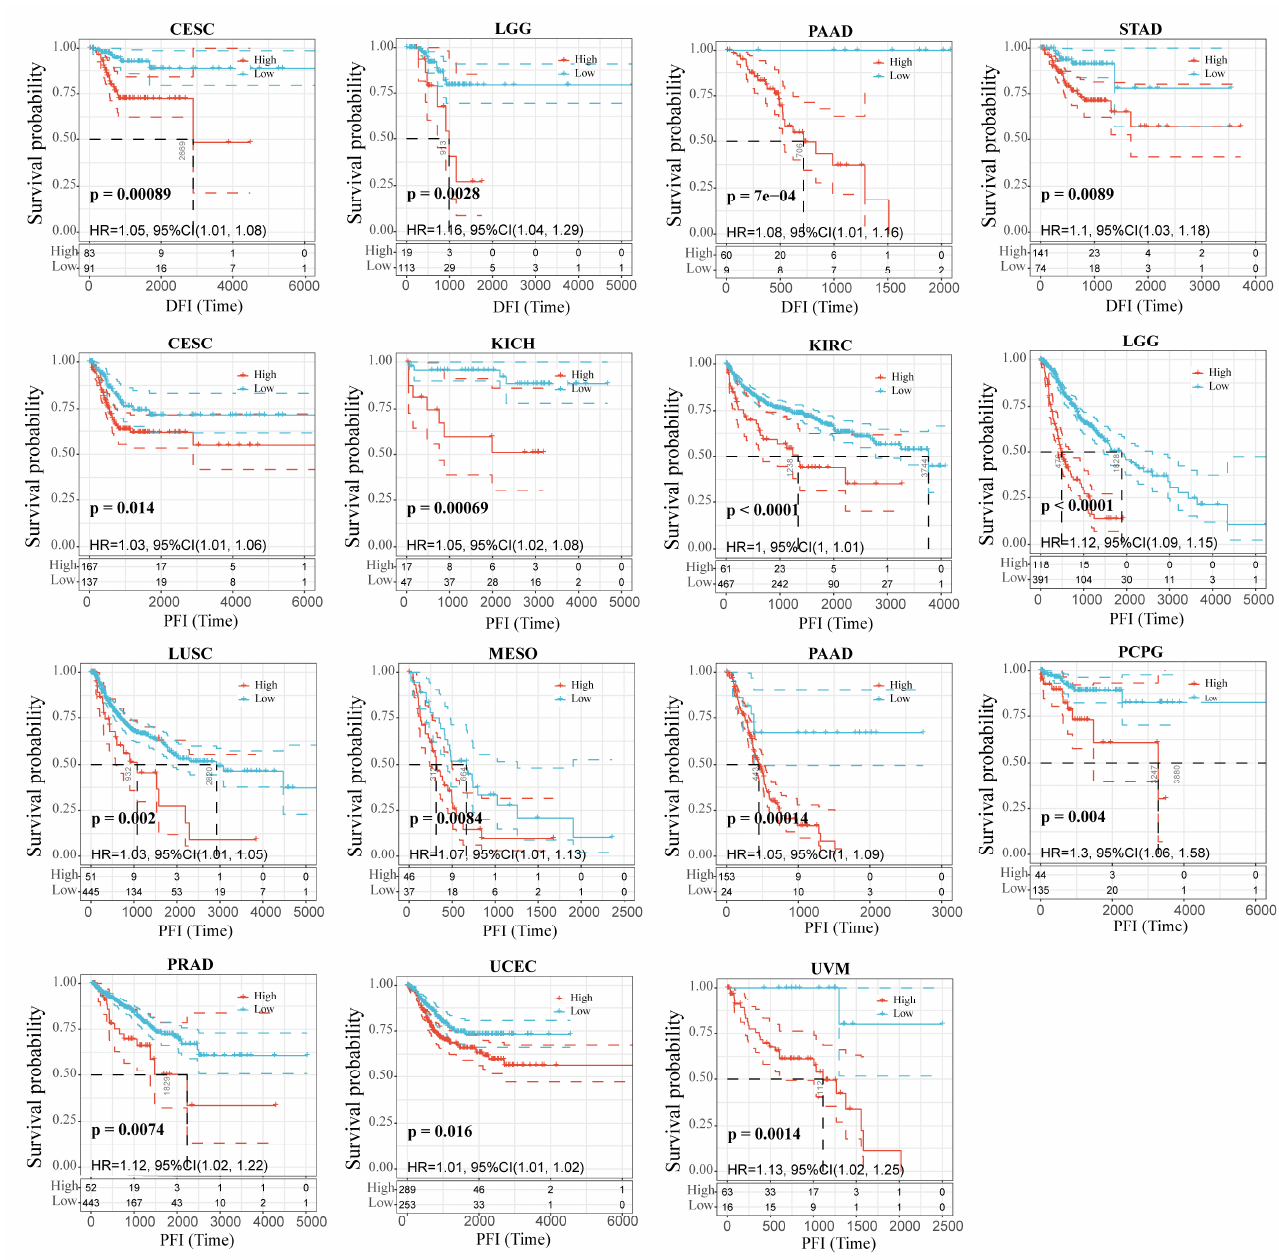
Figure 3. Correlation between RAB42 expression and DFI and PFI.